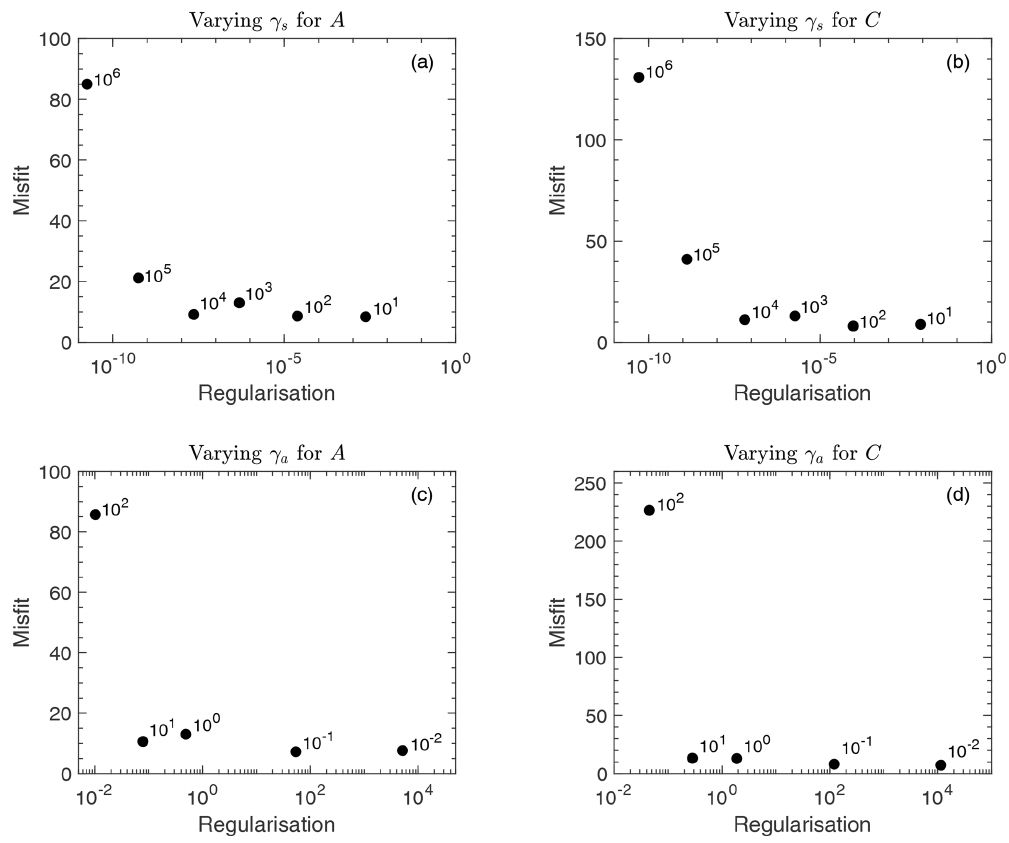
Figure A1. L curves used to determine the amount of regularisation to apply in the optimisation of the A and C fields. Panel (a) is the misfit term ( I in Eq. 6) plotted as a function of the regularisation applied ( R (from Eq. 7) divided by γ 2 ) whilst varying γ sA (value indicated by sA label), with γ sC = 1000 and γ aA/C = 1000. Panel (b) is the misfit term plotted as a function of R/γ 2 whilst varying γ sC , with γ sA = 1 sC and γ aA/C = 1000. Panel (c) is the misfit term plotted as a function of R/γ 2 whilst varying γ aA , with γ aC = 1 and γ sA/C = 1000. Panel aA (d) is the misfit term plotted as a function of R/γ 2 whilst varying γ aC , with γ aA = 1 and γ sA/C = 1000. aC